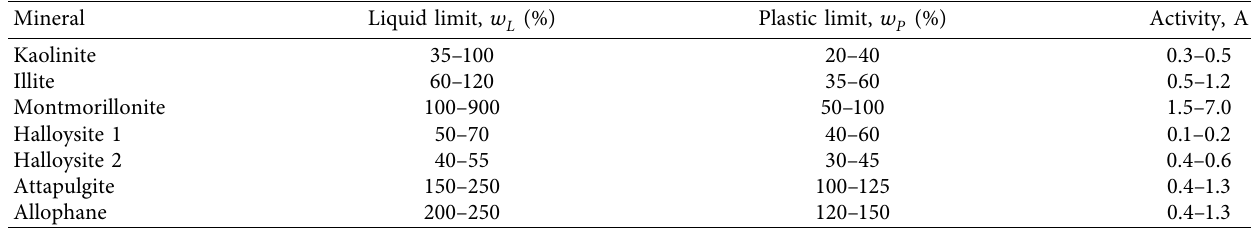
Table 2: Values of liquid limit, plastic limit, and activity of some clay minerals [8].